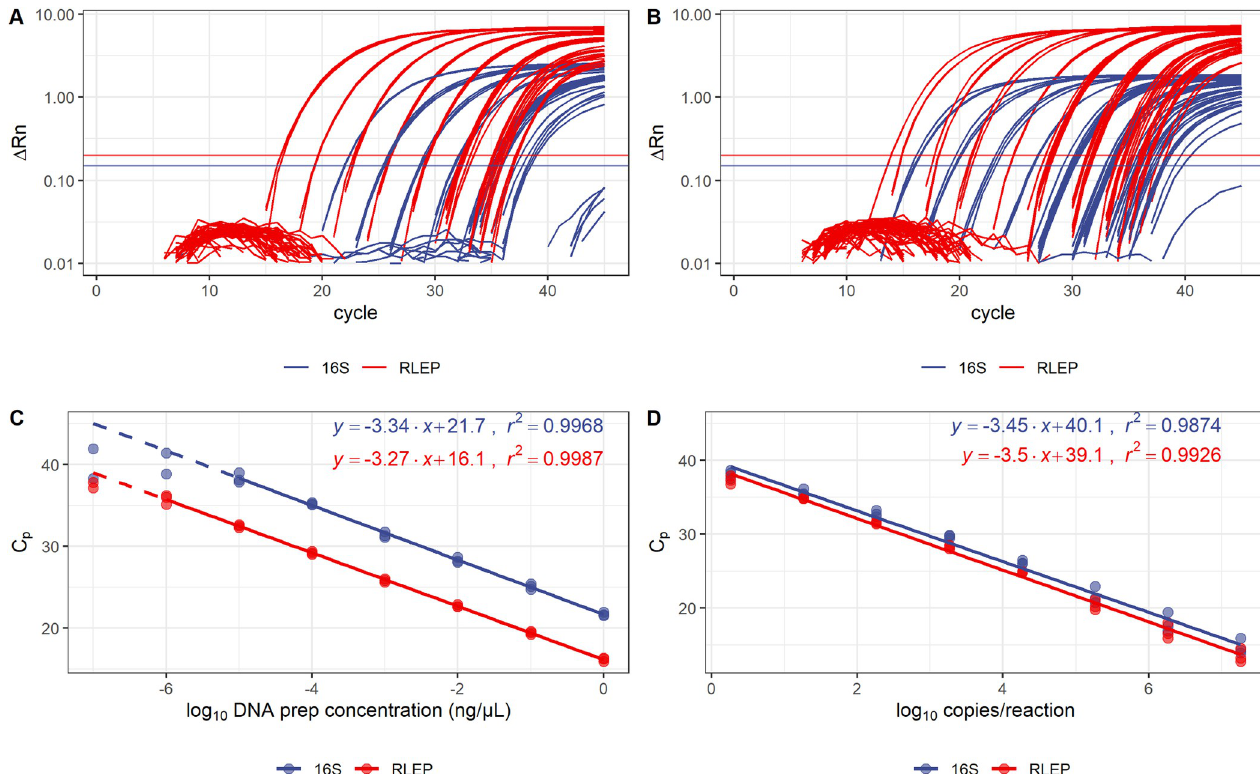
Fig 1. Standard curves of the amplification of 16S rRNA and RLEP targets in M . leprae DNA and in a synthetic construct. Panels A and C show the calibration curves obtained using M . leprae DNA, diluted in total DNA extracted from M . leprae -negative whole blood. Continuous lines show the linear range and the dashed lines are extrapolations towards the non-linear range. Efficiencies calculated from the linear ranges were 99.2% for 16S rRNA and 102.2% for RLEP, and r 2 were 0.9968 and 0.9987, respectively. Panels B and D show the calibration curves obtained using a synthetic gene containing one copy of each target per molecule, diluted in total DNA extracted from M . leprae -negative whole blood. The efficiencies were 94.9% for 16S rRNA and 93% for RLEP, and r 2 were 0.9874 and 0.9926,